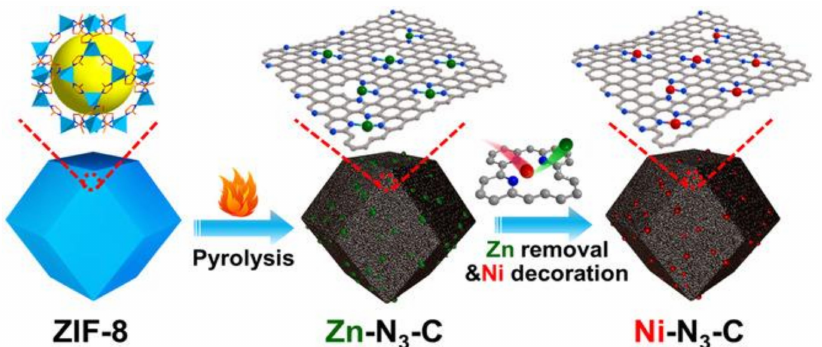
Figure 4. Fabrication of low-coordination single-atom Ni electrocatalysts via a PSMS strategy. Reprinted with permission from Ref. [75]. Copyright 2021,